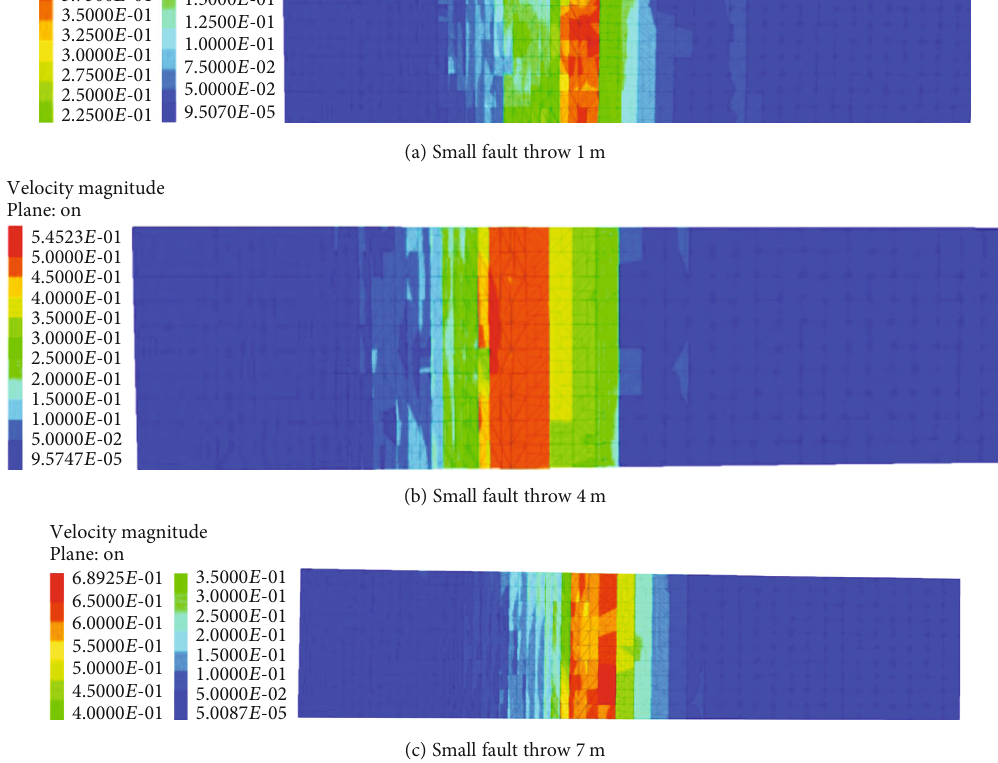
Figure 6: The displacement rate cloud map of the overburden layer when the mining face is advanced to the fault